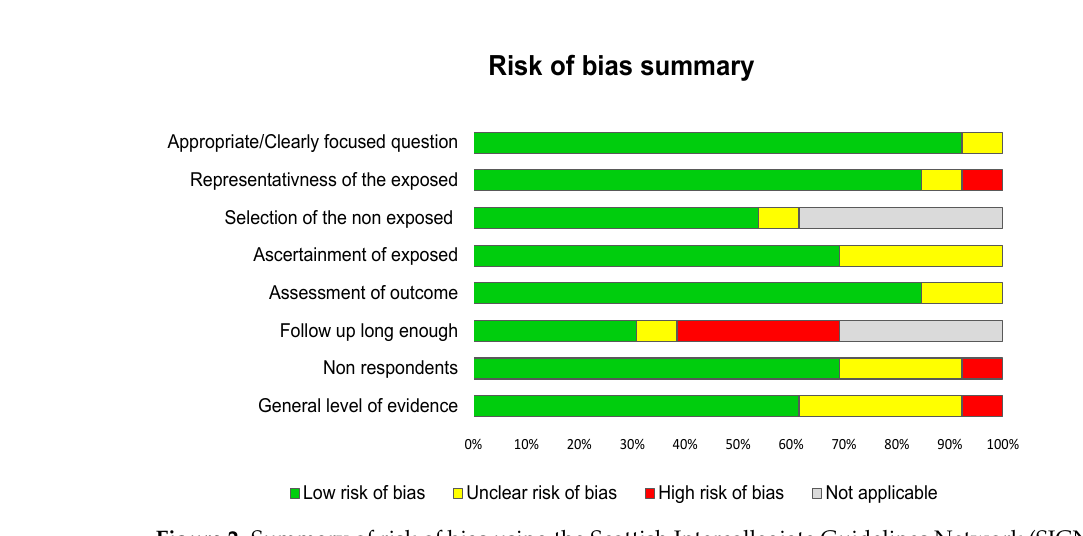
Figure 2. Summary of risk of bias using the Scottish Intercollegiate Guidelines Network (SIGN).